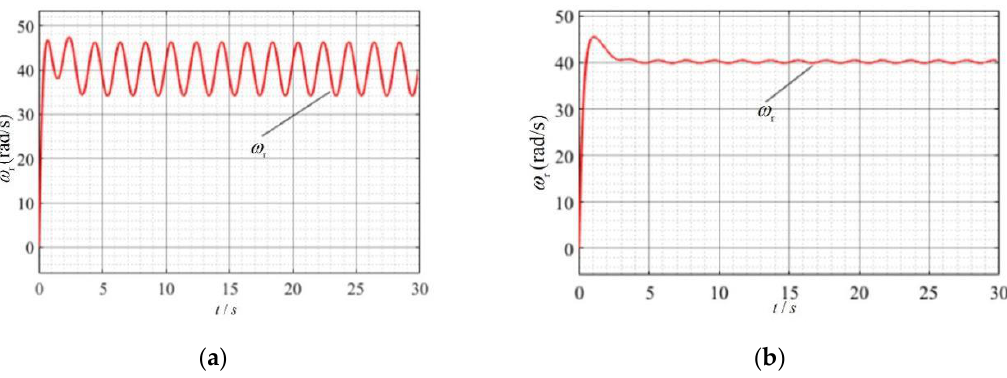
Figure 17. Output speed curve when the value of 𝐹 f (𝑠) changes: ( a ) scheme (a); ( b ) scheme (b).